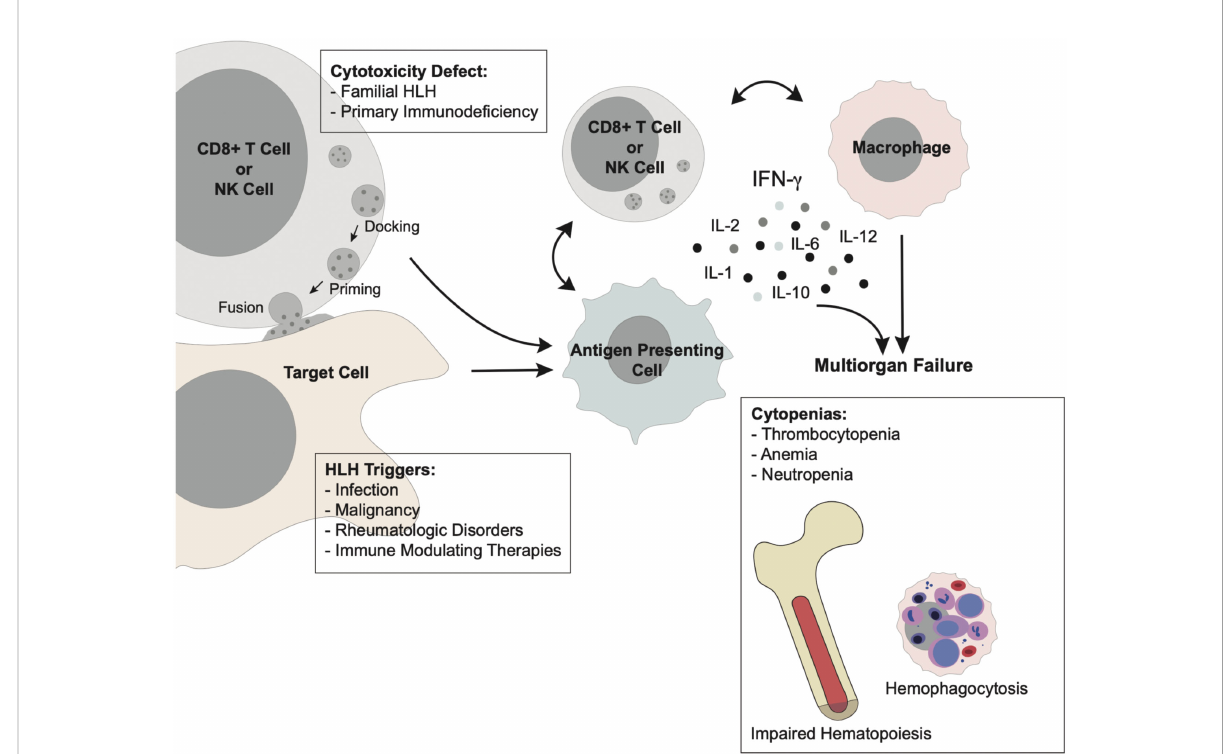
FIGURE 2 Pathophysiology of HLH Primary HLH arises from defective cytotoxicity in CD8+ T cells or NK cells, allowing persistence of an antigenic stimulus. Secondary HLH arises from unchecked immune activation secondary to infection, malignancy, rheumatologic disorders, or immune- modulating therapy. This immune activation acts through a common pathway in which uncontrolled stimulation of CD8+ T cells and macrophages results in hypercytokinemia which drives the clinical manifestations of multi-organ failure. Cytopenias in the form of neutropenia, anemia, and thrombocytopenia are ubiquitous in HLH downstream of excessive production of IFN- g and other in fl ammatory cytokines. This “ cytokine storm ” suppresses normal hematopoiesis and results in diffuse hemophagocytosis by activated